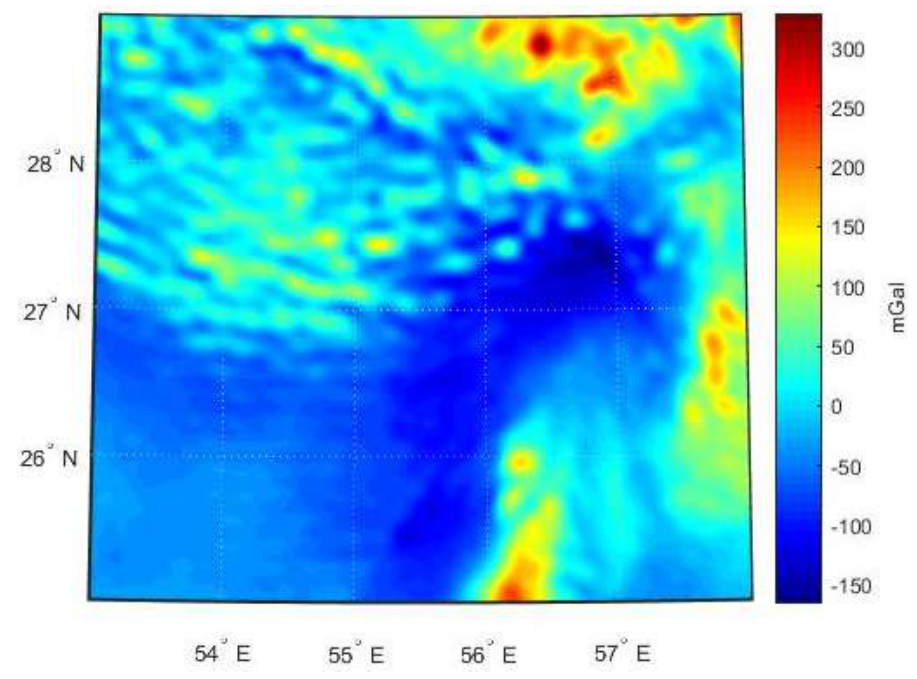
Figure 3. The variation of terrestrial and marine free-air gravity anomalies over the study area. Table 2. The statistics of the available free air gravity anomalies and the reference field in the study area.